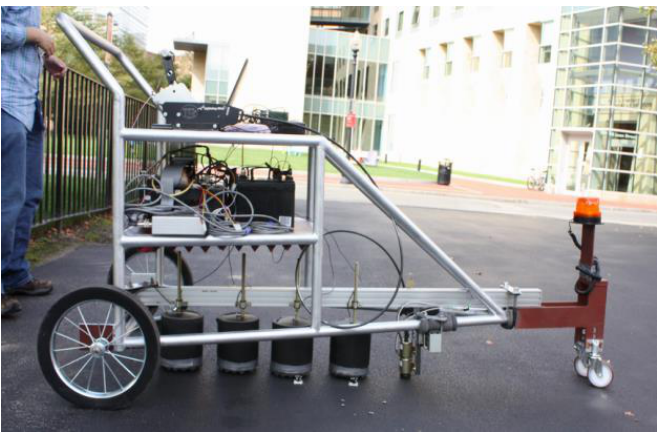
Figure 13. Mobile testing at Northeastern University Campus.